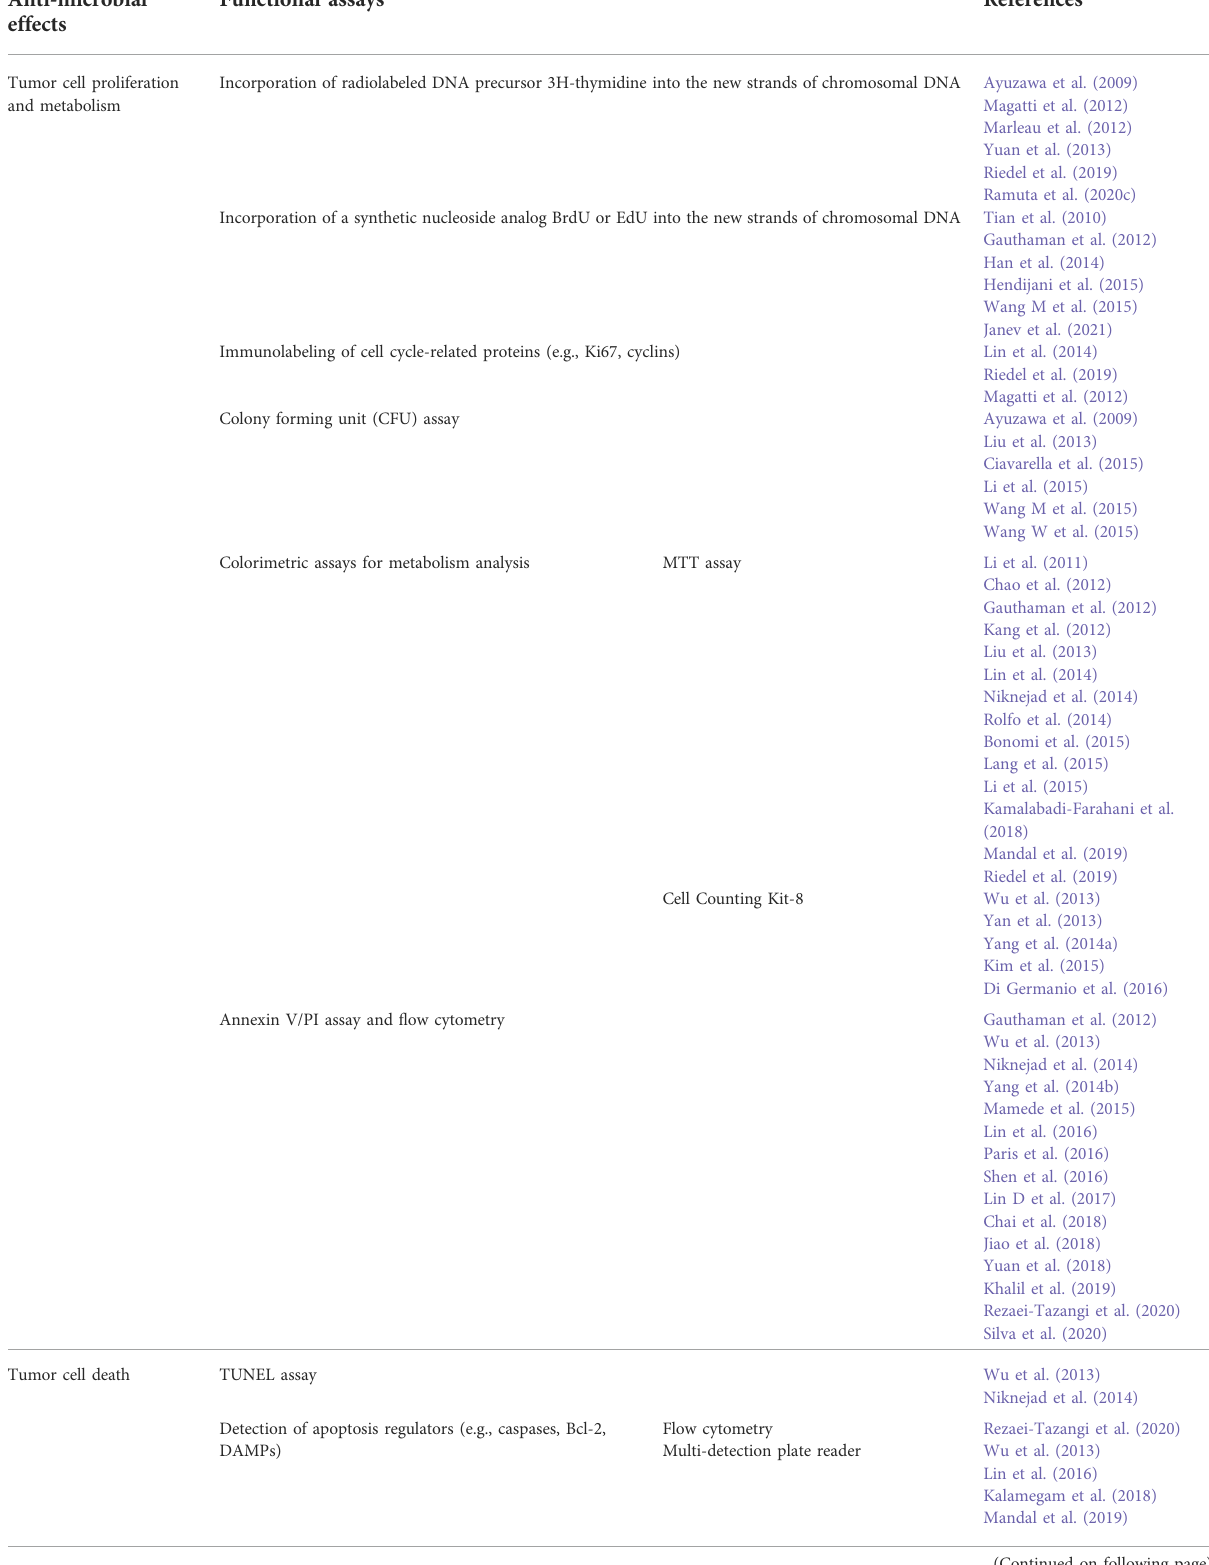
TABLE 2 Summary of assays used to detect antitumor and antimicrobial effects of